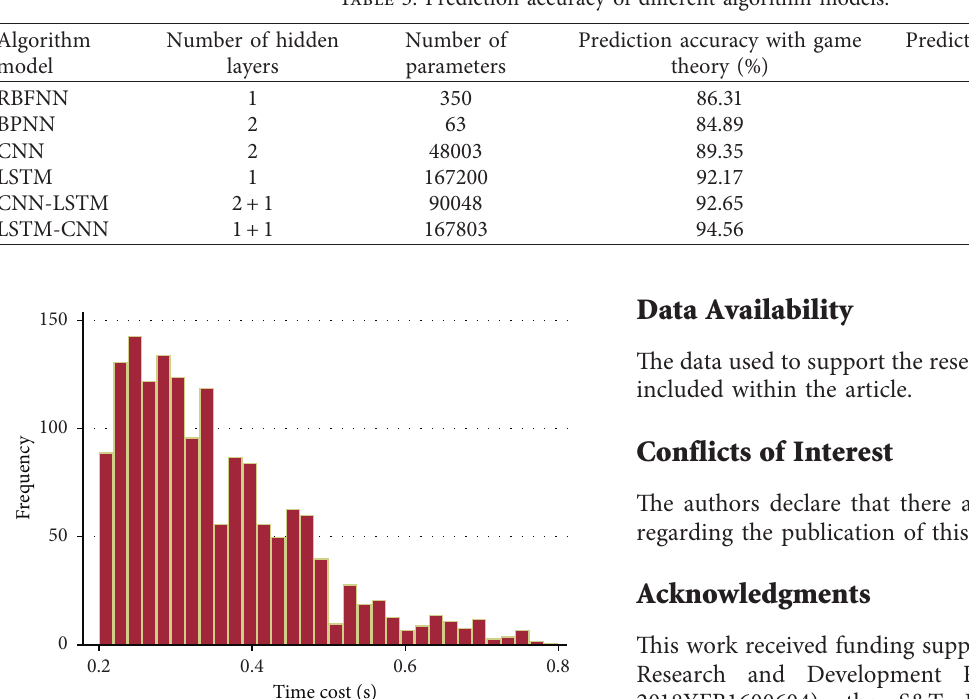
Table 3: Prediction accuracy of different algorithm models.